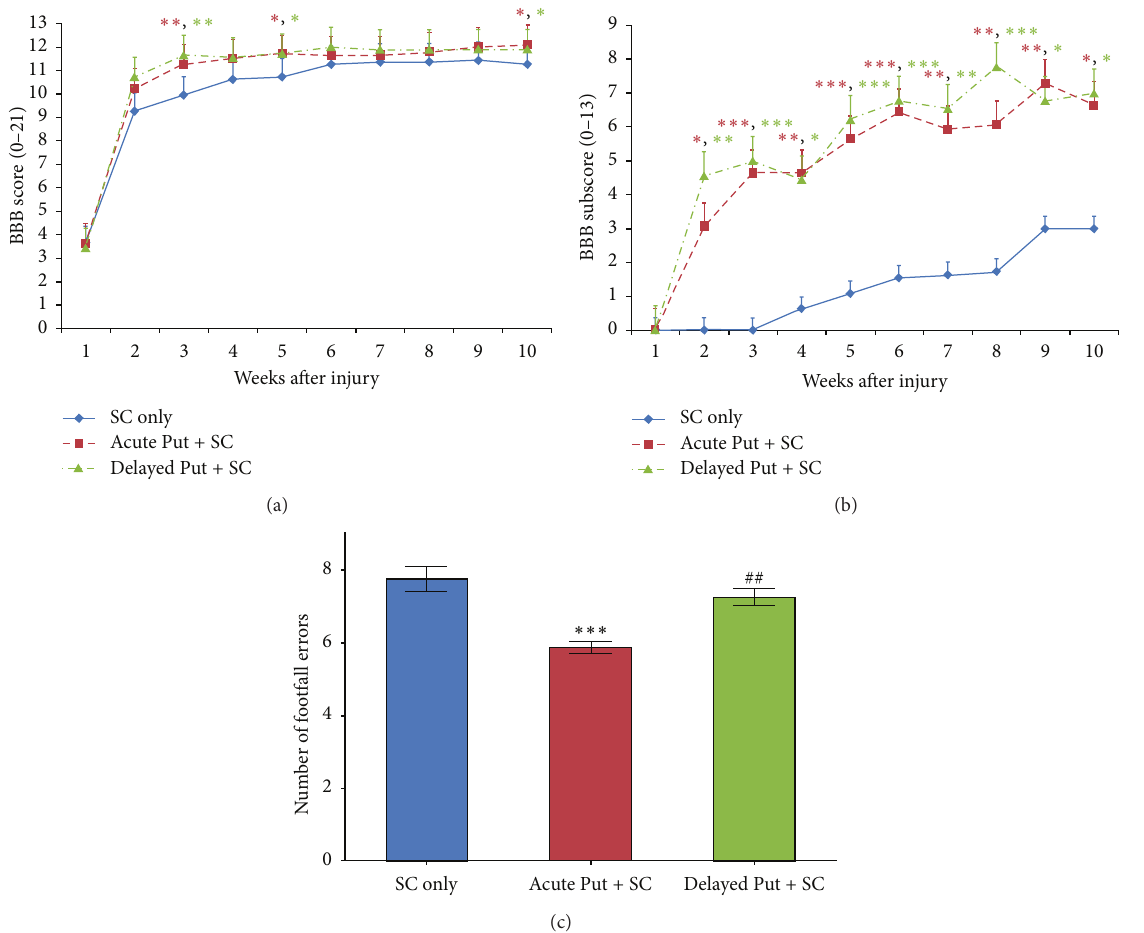
Figure 6: Putrescine supplementation enhances the functional outcomes obtained with SC implants. Assessment of open field locomotor performance with the (a) BBB score and subsequent (b) BBB subscore analysis shows that animals receiving either acute or delayed putrescine have improved walking behavior over SC implanted, vehicle controls. Improvements in foot and tail positioning, as measured by the BBB subscore, exhibit a more acute and stable pattern of recovery. (c) Recording the number of footfalls that occur while traversing a horizontal grid walk test also showed an improvement in hind paw positioning when acute putrescine was administered (red) compared to vehicle only controls (blue). Delayed putrescine (green) was without effect. Statistical significance indicated at ∗ 𝑝 < 0.05 , ∗∗ 𝑝 < 0.01 , and ∗∗∗ 𝑝 < 0.001 compared to the vehicle control group or ## 𝑝 < 0.01 compared to acute